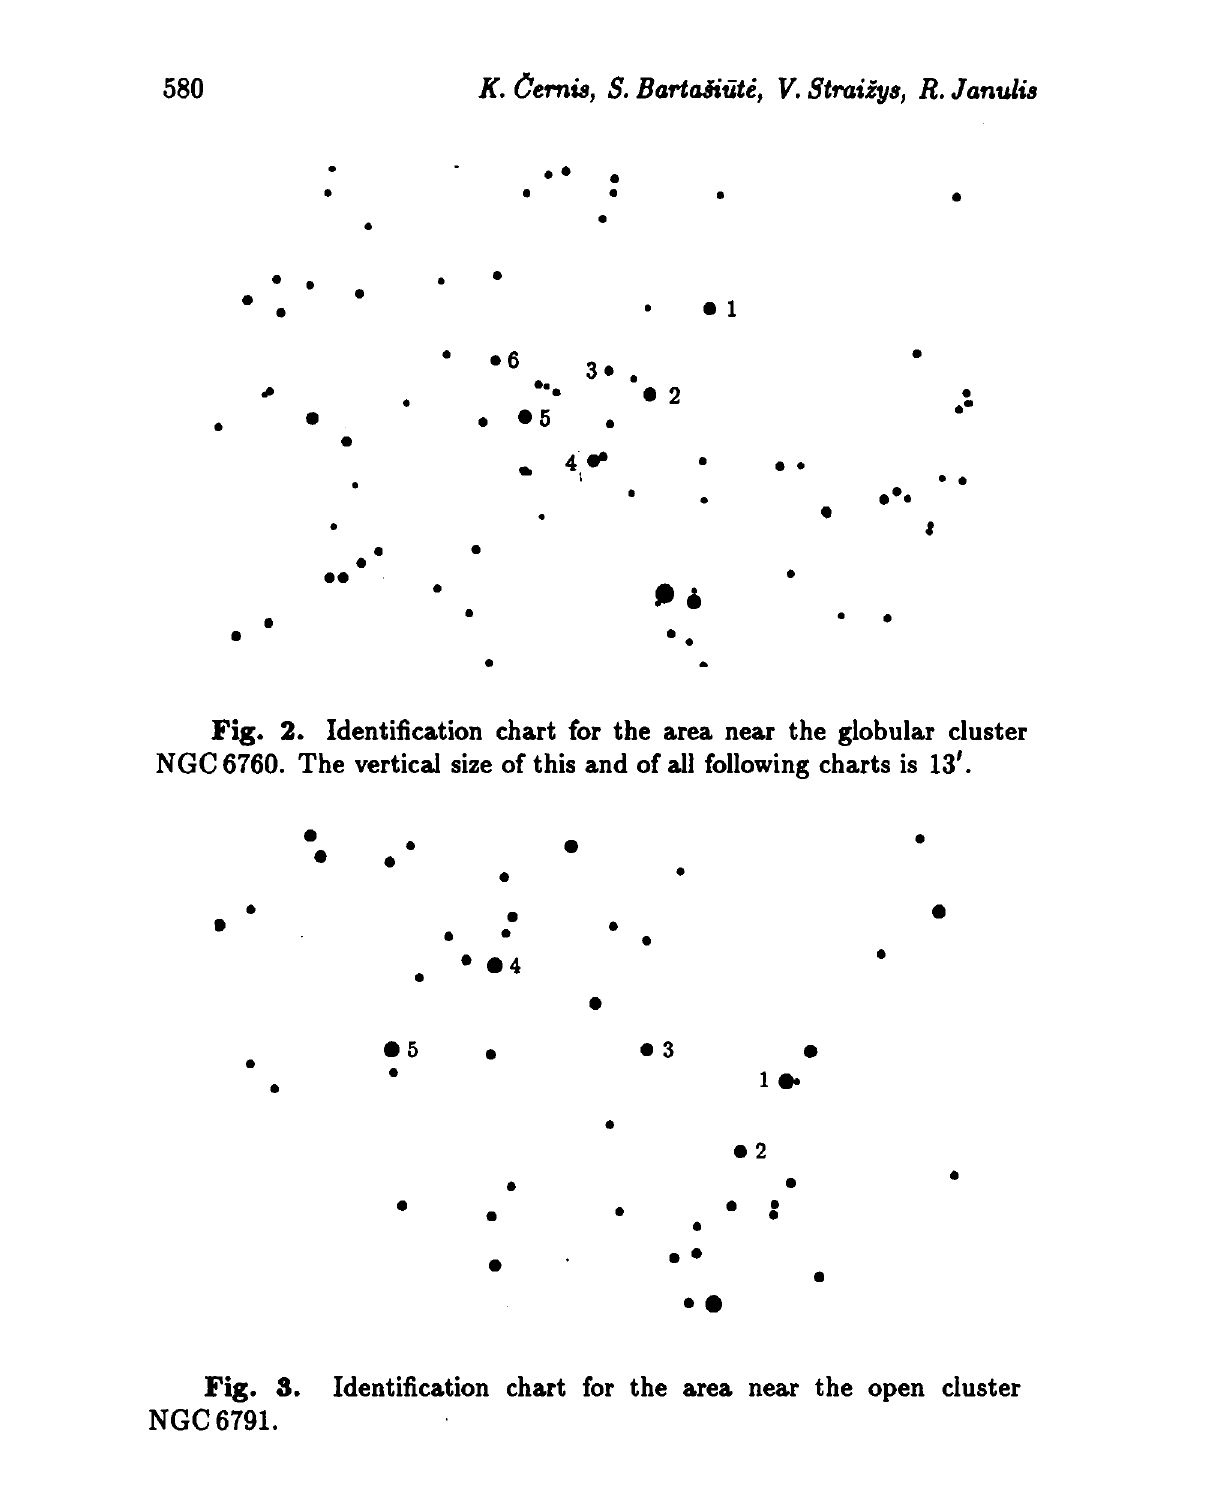
Fig. 3. Identification chart for the area near the open cluster